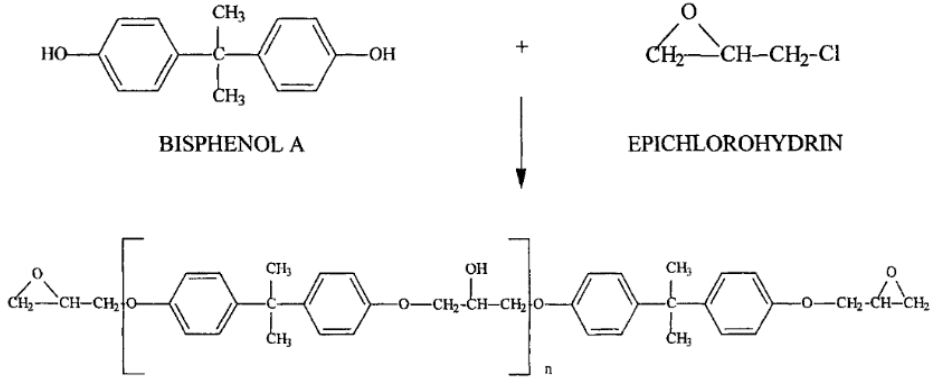
Figure 3. Typical Bisphenol A (BPA) epoxy resin [42].